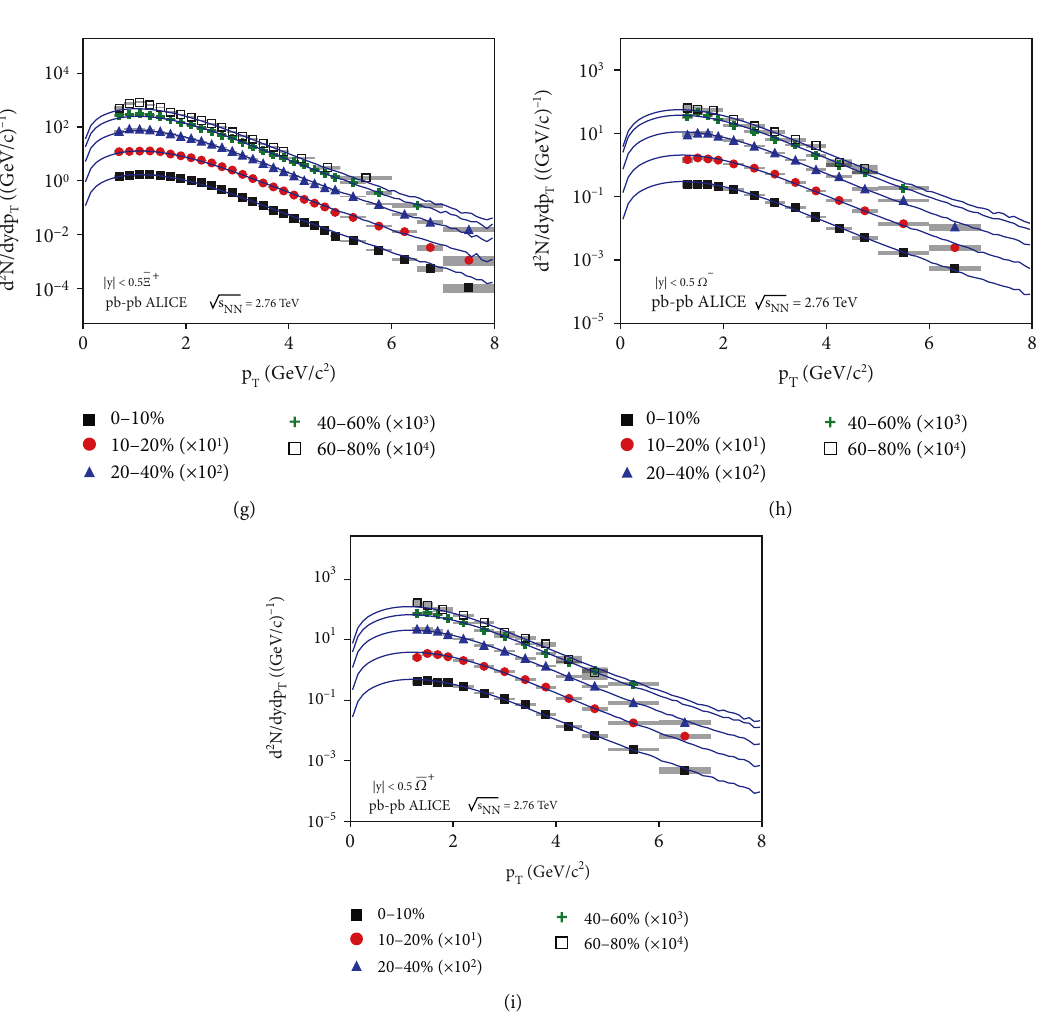
K + + K − , (b) ð K ∗ 0 + (cid:1) K ∗ 0 Þ / (b), (c) K 0 ϕ , (e) Λ , (f) Ξ − , (g) (cid:1) Ξ + , (h) Ω − , and (i) (cid:1) Ω + in Pb – Pb collisions with Figure 1: The p S , (d) T spectra of (a) ffiffiffiffiffiffiffi p s = 2 : 76 TeV. The symbols represent the data measured by the ALICE di ff erent centrality and mid-pseudorapidity intervals at NN Collaboration [39 – 41]. The solid curves represent the Monte Carlo results, based on the probability density function Equation (2) and the p T expression in Equation